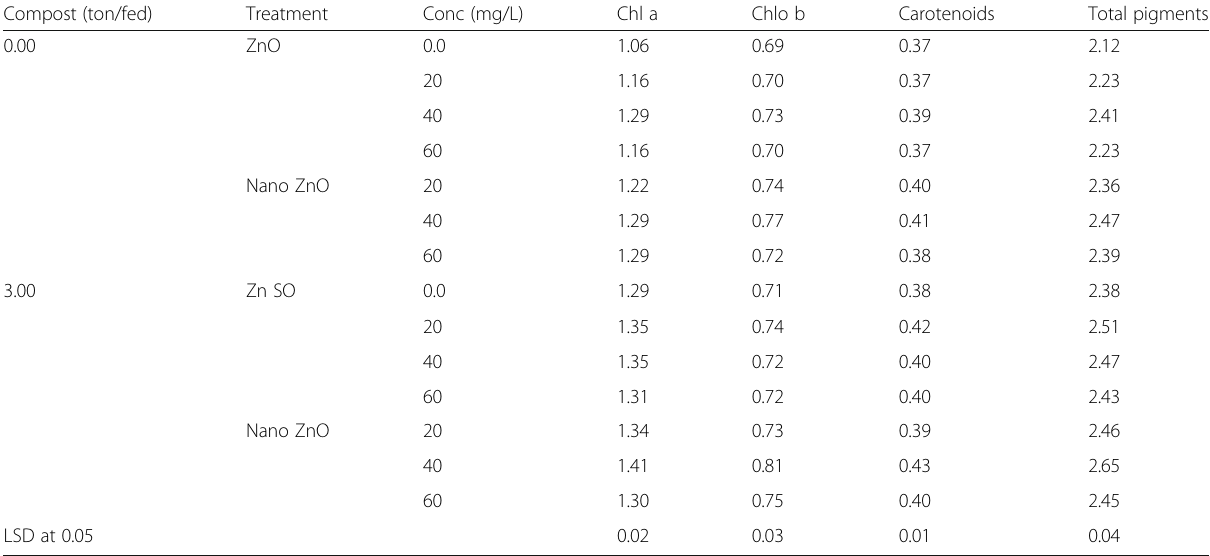
Table 10 Effect of compost and/or ZnO or nano ZnO different concentrations on photosynthetic pigments ( μ g/g fresh wt) of flax leaves under sandy soil Compost (ton/fed)